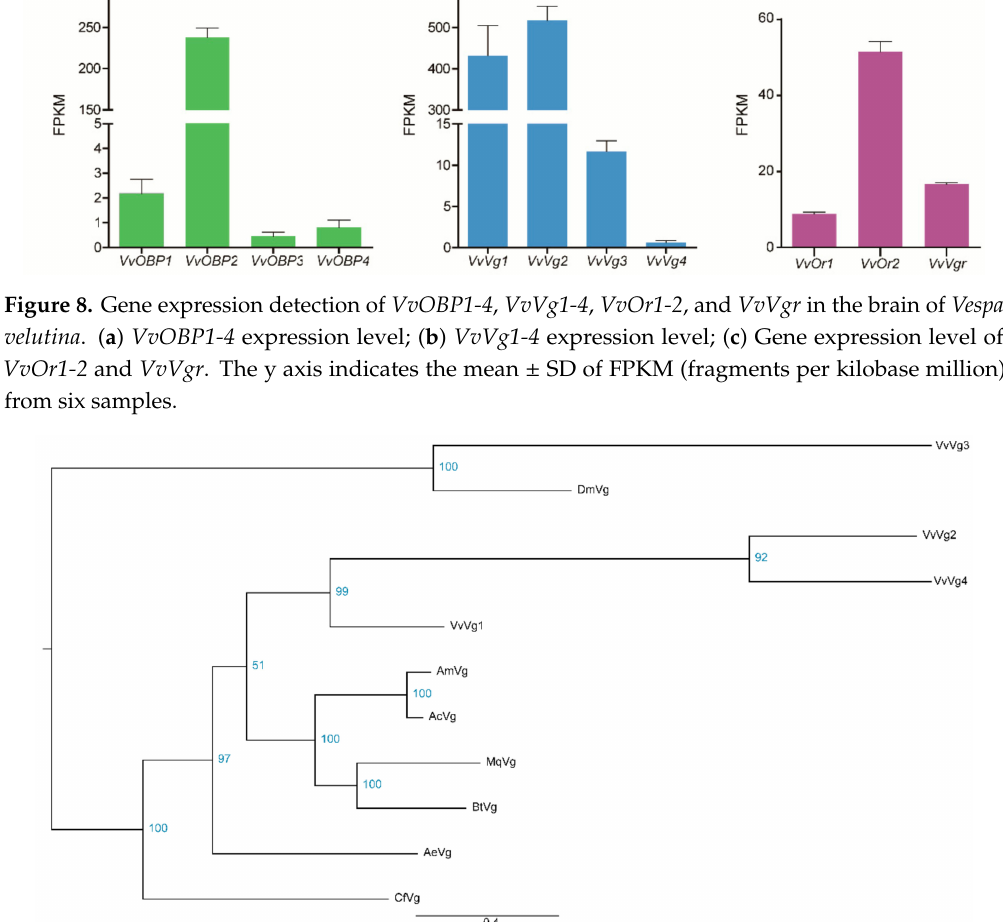
Figure 9. Phylogenetic analysis of of insect vitellogenins (Vgs) in the brain of Vespa velutina and other seven insects. Vv, Vespa velutina ; Am, Apis mellifera ; Ac, Apis cerana ; Mq, Melipona quadrifasciata ; Bt, Bombus terrestris ; Ae, Acromyrmex echinatior ; Cf, Camponotus floridanus ; Dm, Drosophila melanogaster